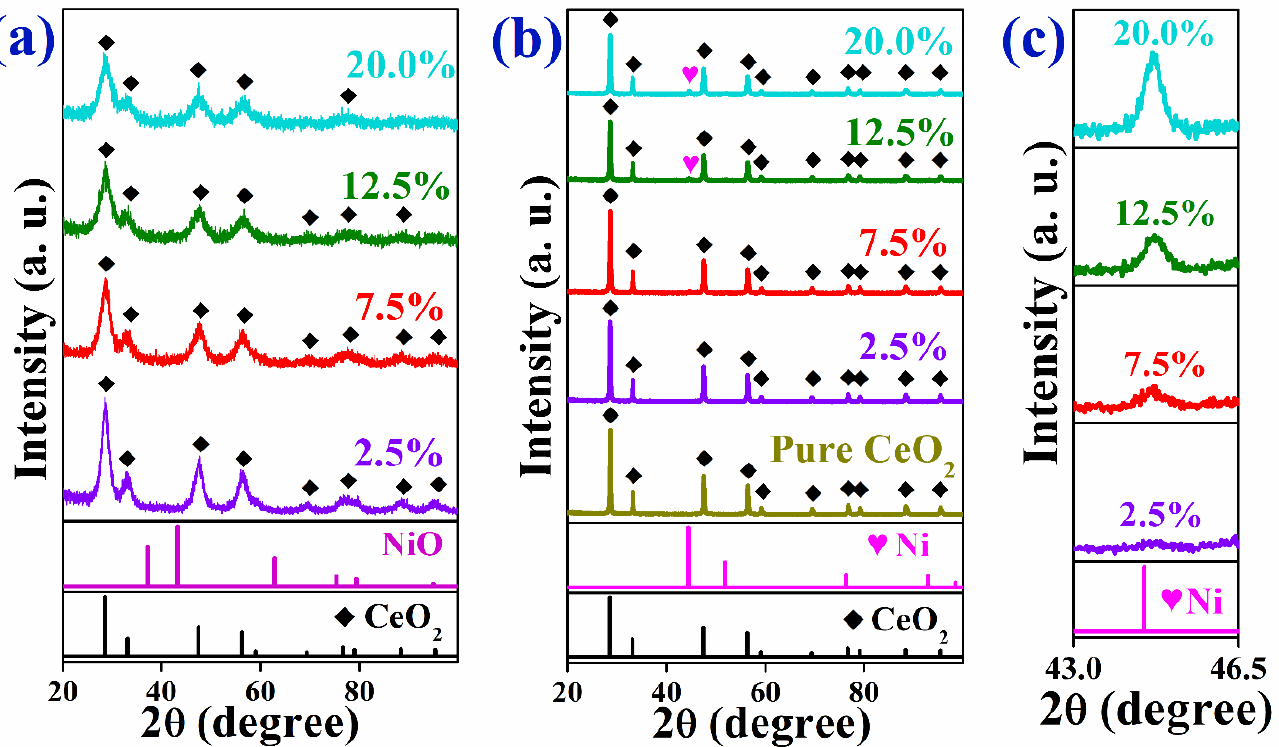
Figure 1. PXRD patterns of calcined ( a ) and reduced ( b ) Ni@CeO 2 catalysts prepared at different Ni-loadings (2.5, 7.5, 12.5, and 20 wt%). ( c ) PXRD patterns of the reduced Ni@CeO 2 catalysts at a slow scanning speed of 0.6°/min (2θ = 43.0–46.5°).